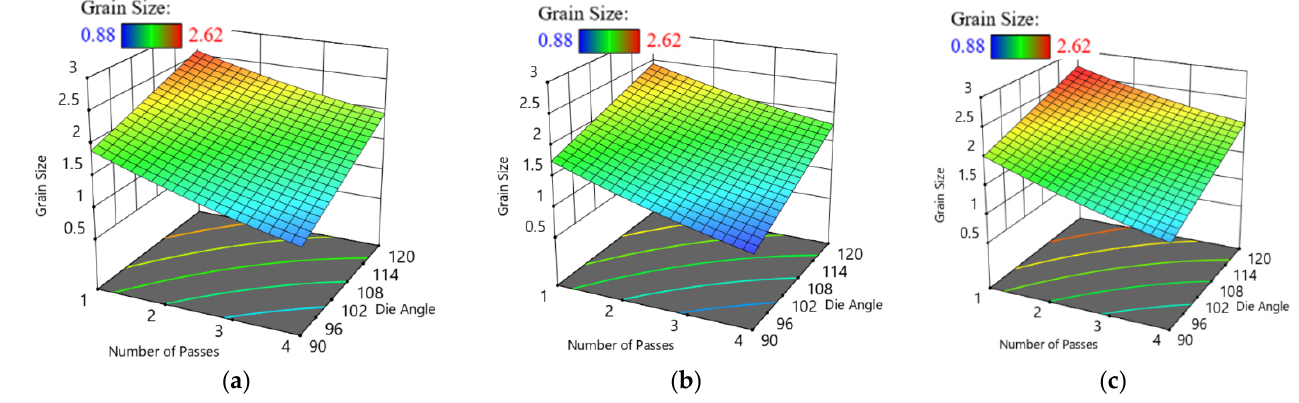
Figure 5. Three-dimensional plot of G R with N and ϕ at route A ( a ), Bc ( b ) and C ( c ).